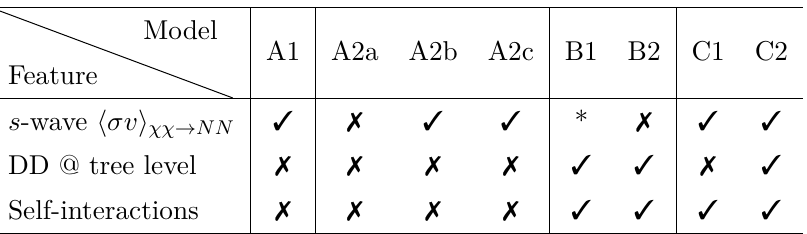
is p -wave, one can easily χχ → NN